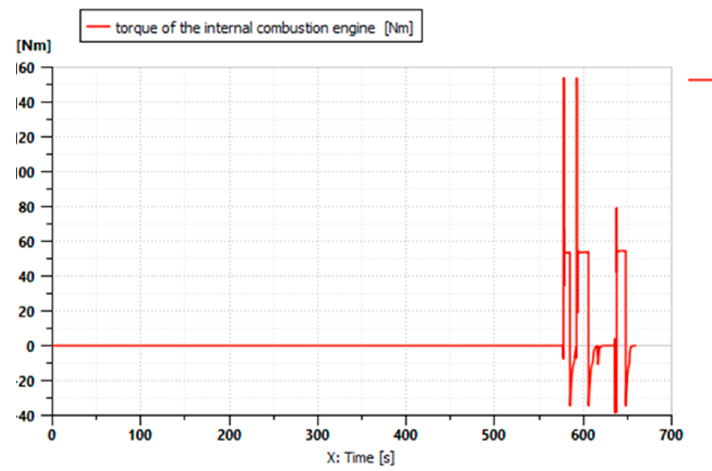
Figure 24. Thermal engine torque.